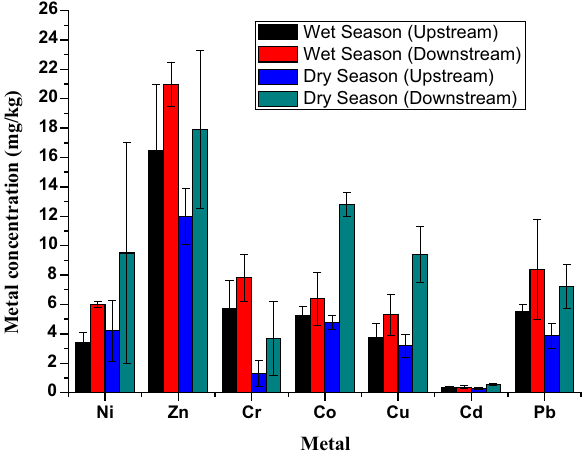
Fig. 2 Seasonal variations of metal concentrations in upstream and